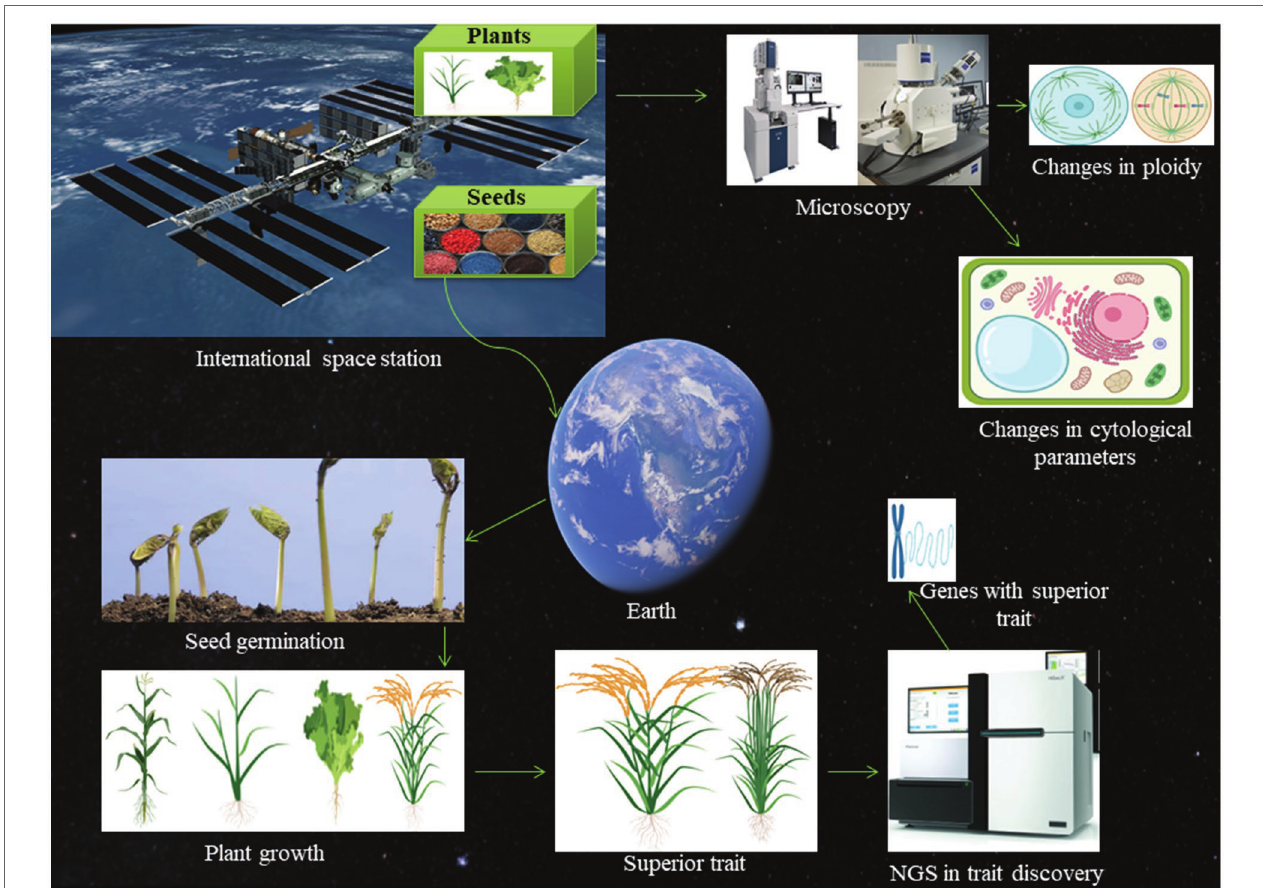
FIGURE 1 | Schematic presentation of the space-breeding platform. The international space station is well-known for its role in space biology research. The plant seeds can be exposed to microgravity and cosmic radiation in space and brought back to the earth and sow for germination. The phenotypic and genotypic parameters can be measured to find the superior trait. The superior trait can be subjected to next-generation sequencing to find potential gene associated with the space environment. Once the gene will be identified, it can be used for molecular breeding to generate crops with the superior trait. The seeds can also be germinated in the space environment itself and grown plants can be brought back to the earth to check for chromosomal aberration, changes in cell shape and size, and alteration in the cell